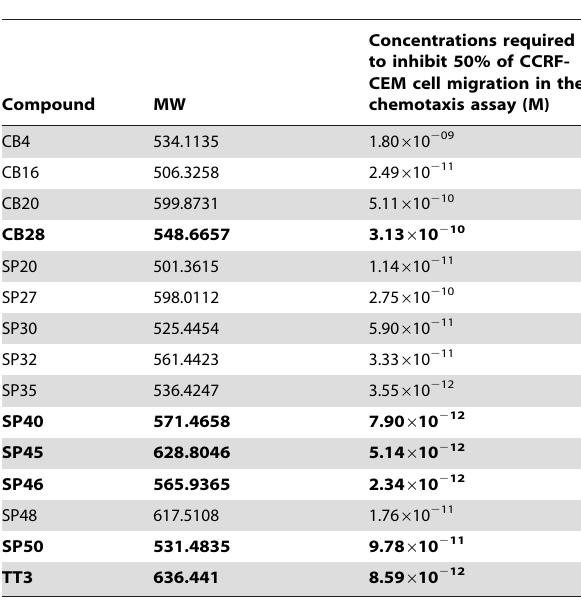
Table 2. Inhibition data from 16 small molecules selected by virtual screening. Antagonists shown to inhibit Treg migration shown in